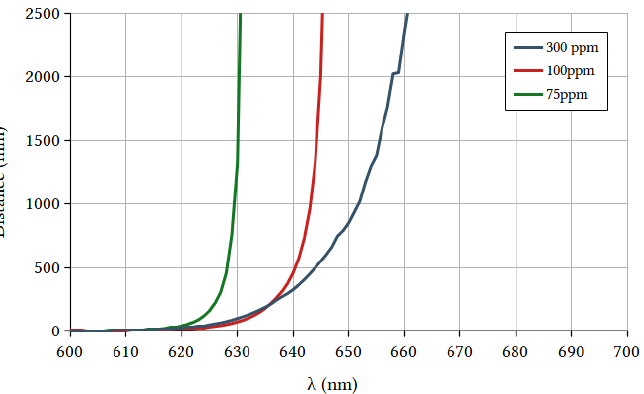
Figure A1. Length traveled by the light inside the slab before halving is power vs. wavelength at different dye concentration: 300 ppm (blue line), 100 ppm (red line), 75 ppm (green line).